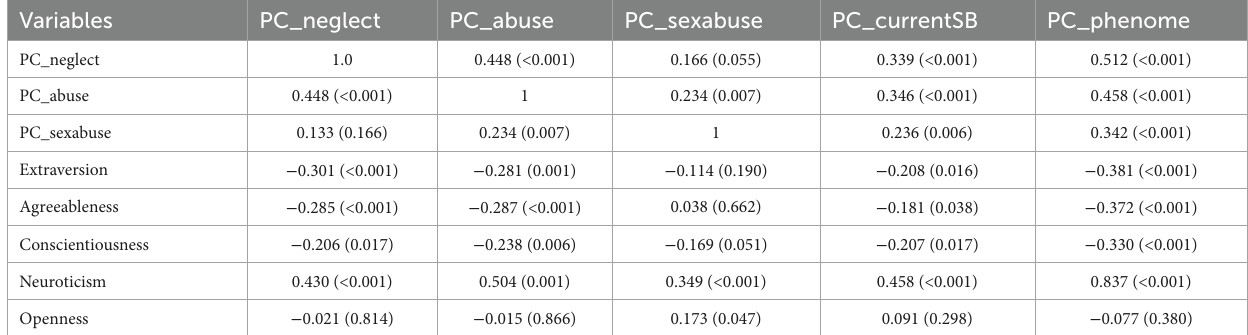
TABLE 4 Intercorrelation matrix.